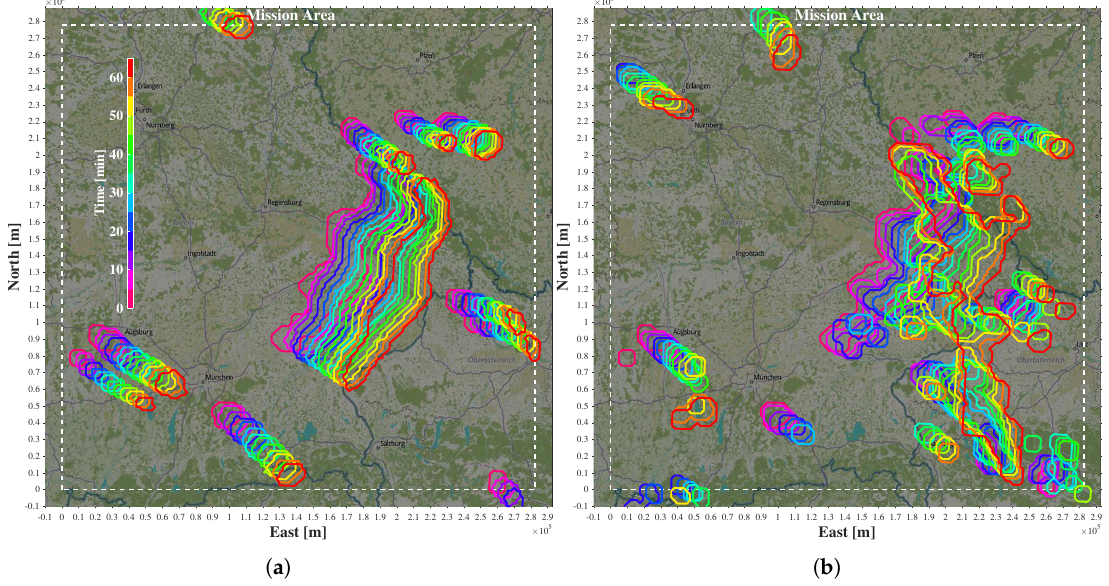
Figure 9. ( a ) Thunderstorm prediction by the nowcast issued 19:05 h for the next hour; and ( b ) subsequent real measurements for the same period of time, both issued by Rad-TRAM.